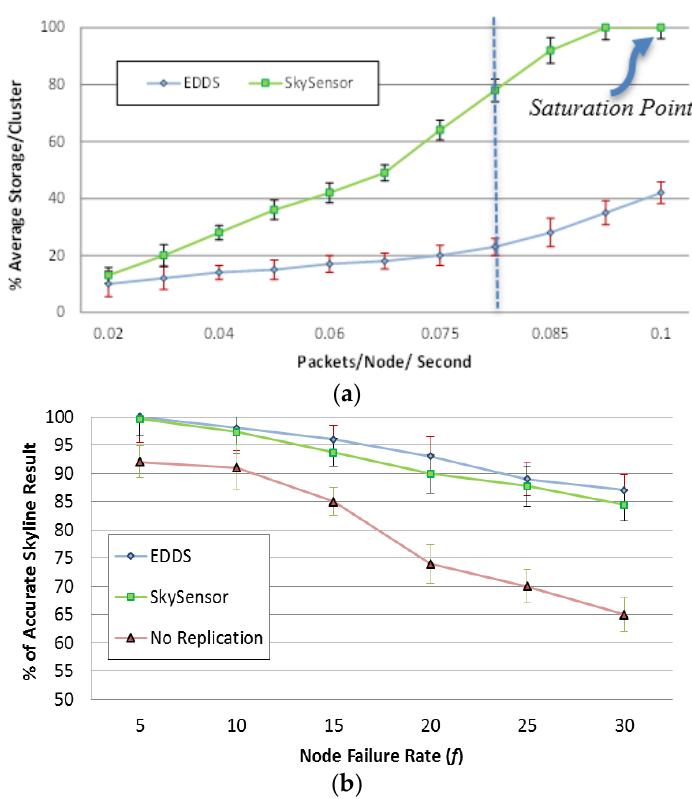
Figure 17. ( a ) Storage efficiency; ( b ) Resilience to node failure